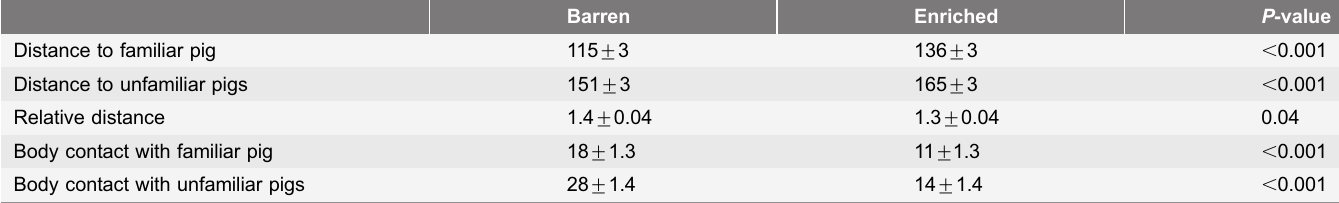
Table 2. Effect of barren and enriched housing on the distances between pigs.